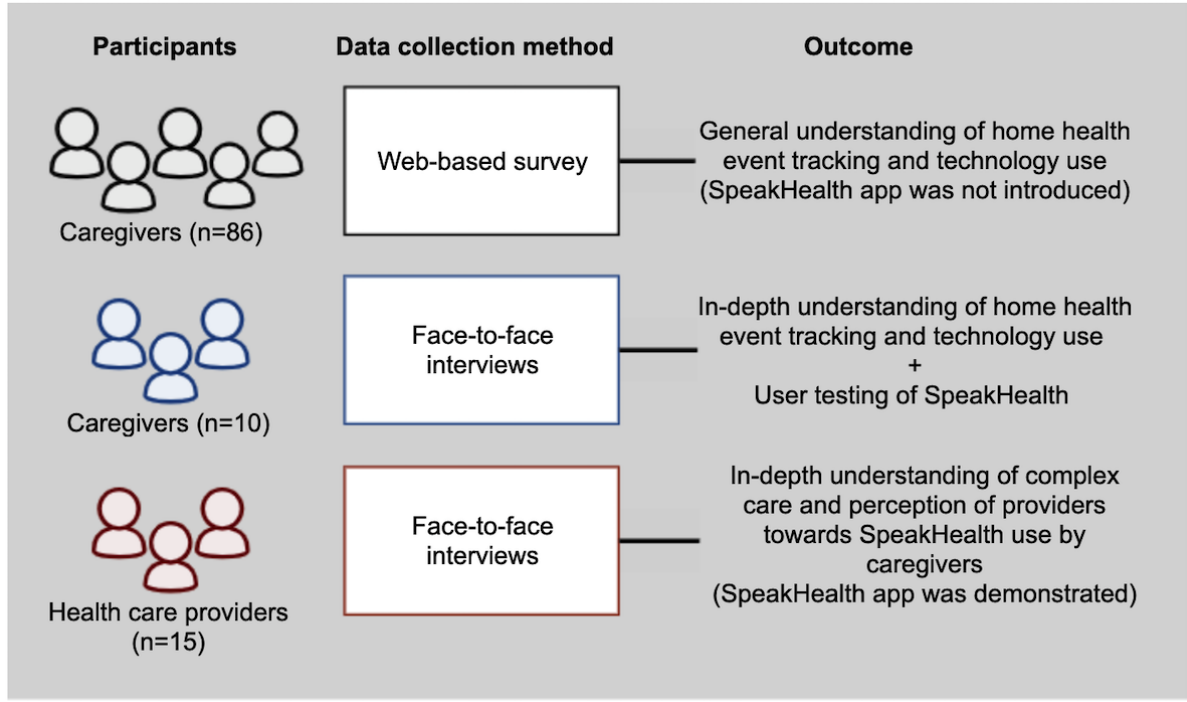
Figure 1. Study design and data